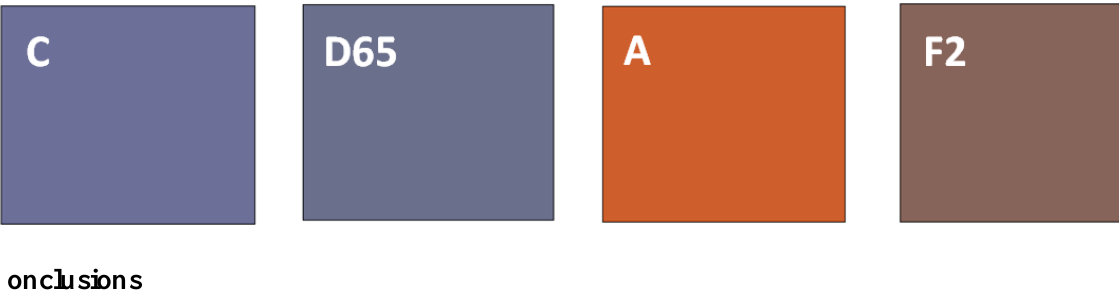
Figure 10. Simulating the effects of source metamerism; an epoxy loaded with quinacridone violet illuminated under various lighting